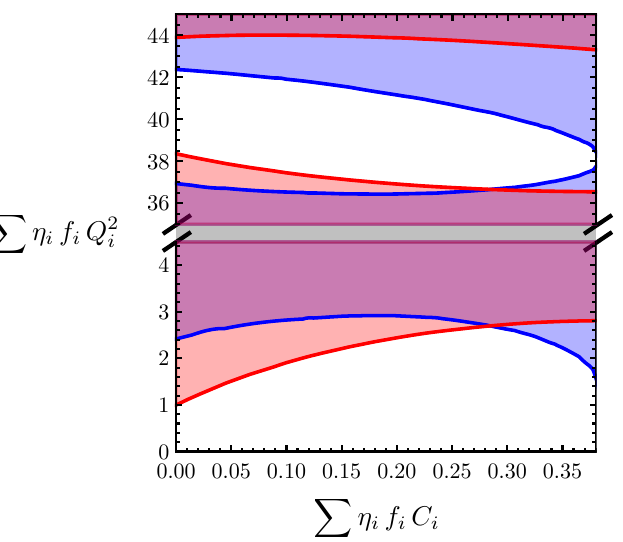
Figure 5 . The allowed electric charge Q i as a function of the color charges C i of new fields due to κ γ − κ g constraints. ATLAS constraints [16] are shaded blue, CMS constraints [17] are shaded